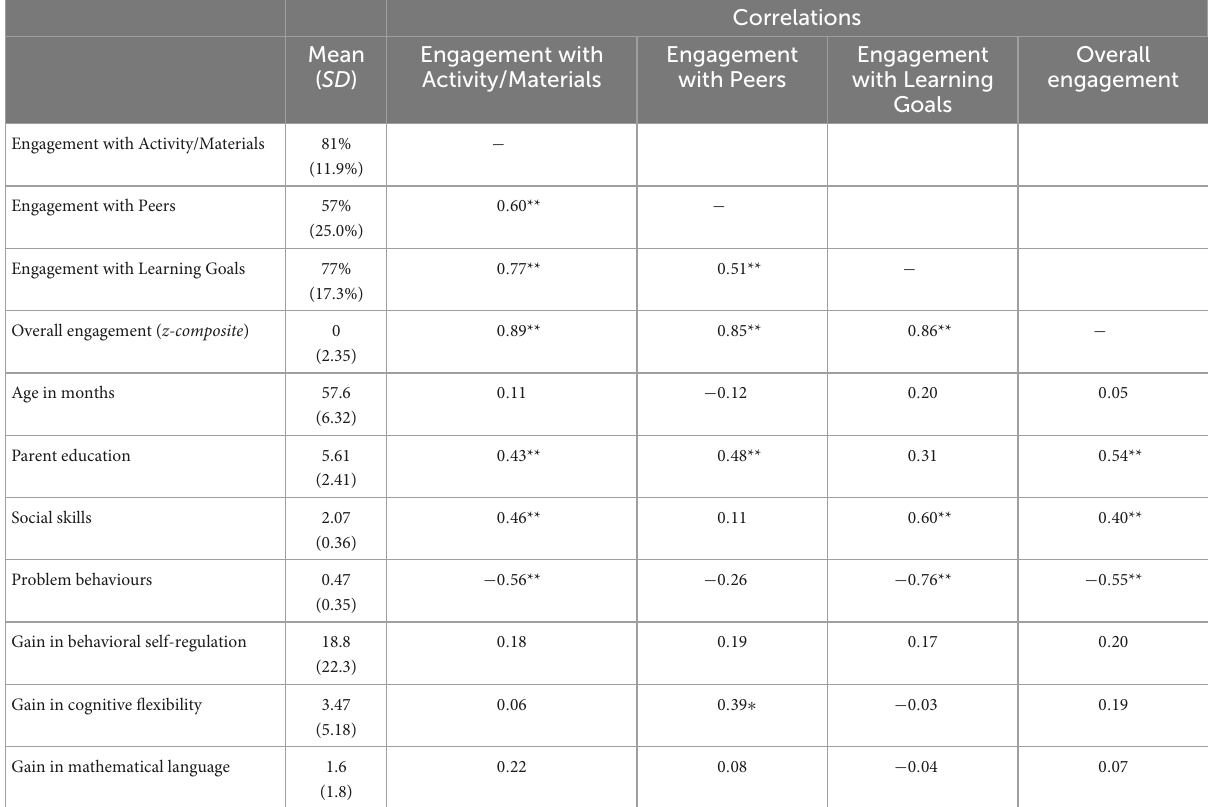
TABLE 2 Descriptive statistics and correlations among dimensions of engagement and variables of interest for Step 4 of the protocol from the Block Play Intervention .